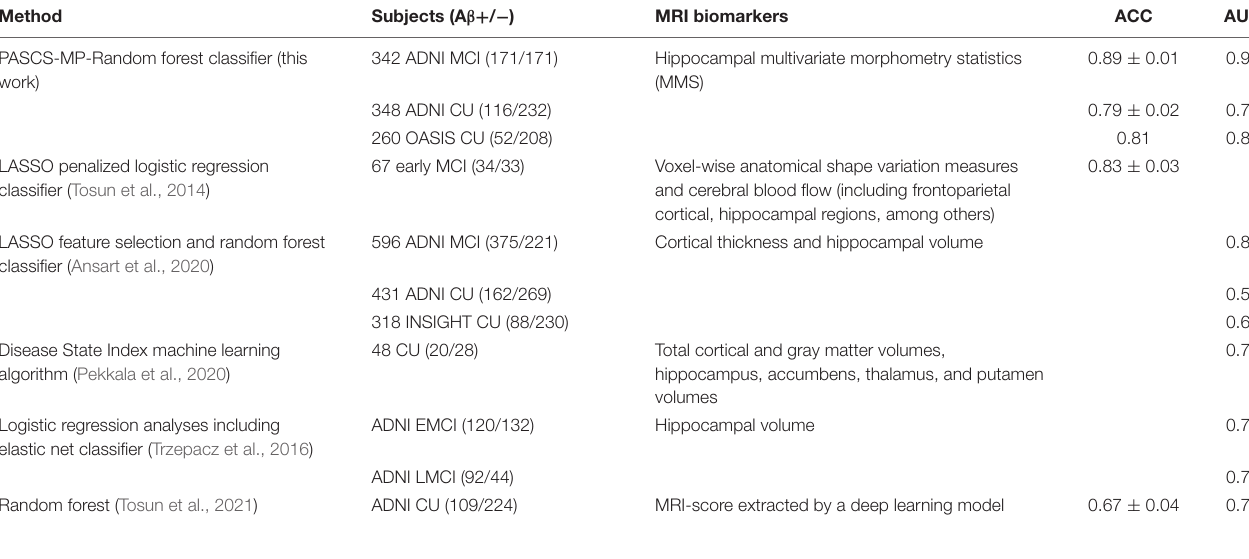
TABLE 3 | Studies to impute A β status from MRI biomarkers in key clinical groups in AD research.